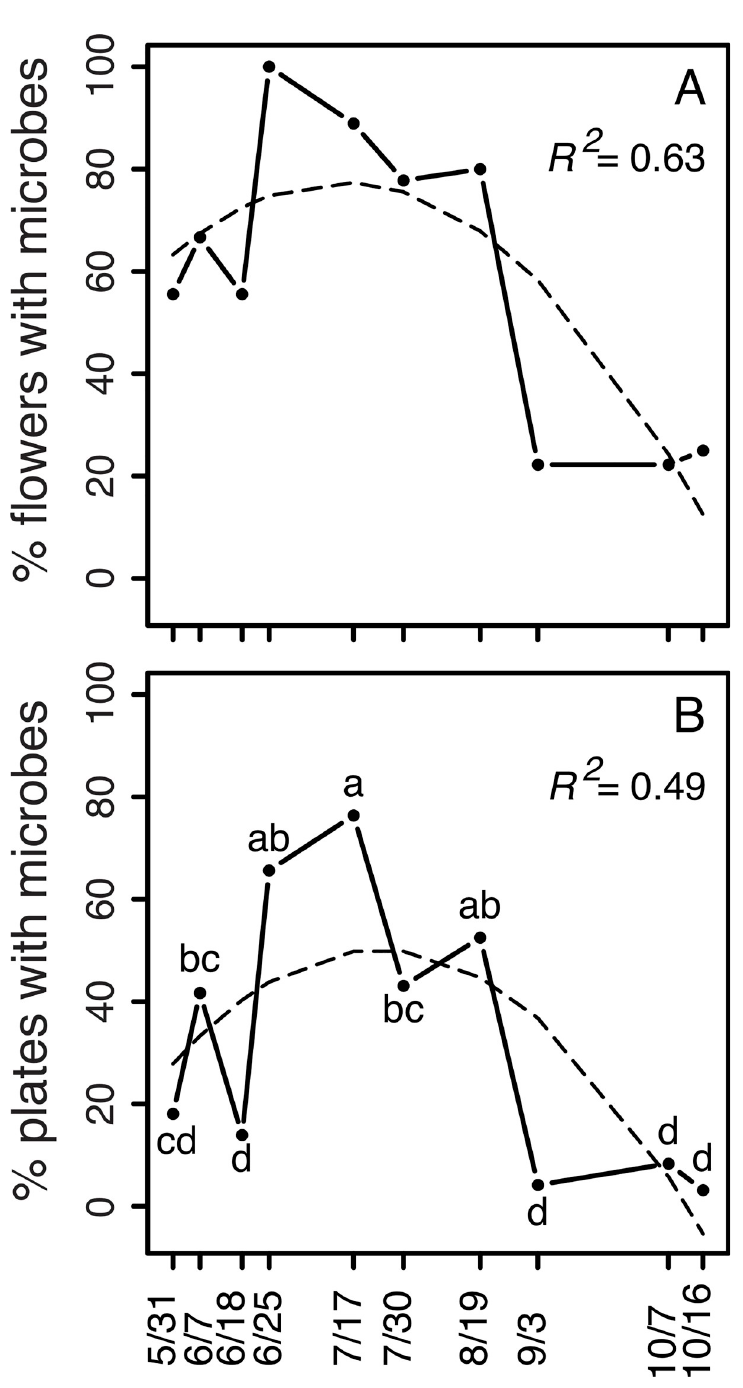
Fig 3. Change in abundance of nectar microbes in D . wrightii flowers during one flowering season (31 May (5/ 31)– 16 October (10/16), 2013). Nectar was collected from plants in the field 1 h before anthesis and without exclusion of flower visitors. (A) Proportion of D . wrightii nectar samples with microbes (N = 9 each, except for 25 June, 19 August and 16 October, with N = 8, 5, and 8, respectively). (B) Proportion of agar plates showing microbe growth (N = 72 each, except for 25 June, 19 August and 16 October, with N = 64, 40, and 64, respectively). Dashed lines describe second-order polynomial regressions. Different letters indicate significant differences between collection dates (GLM, p <